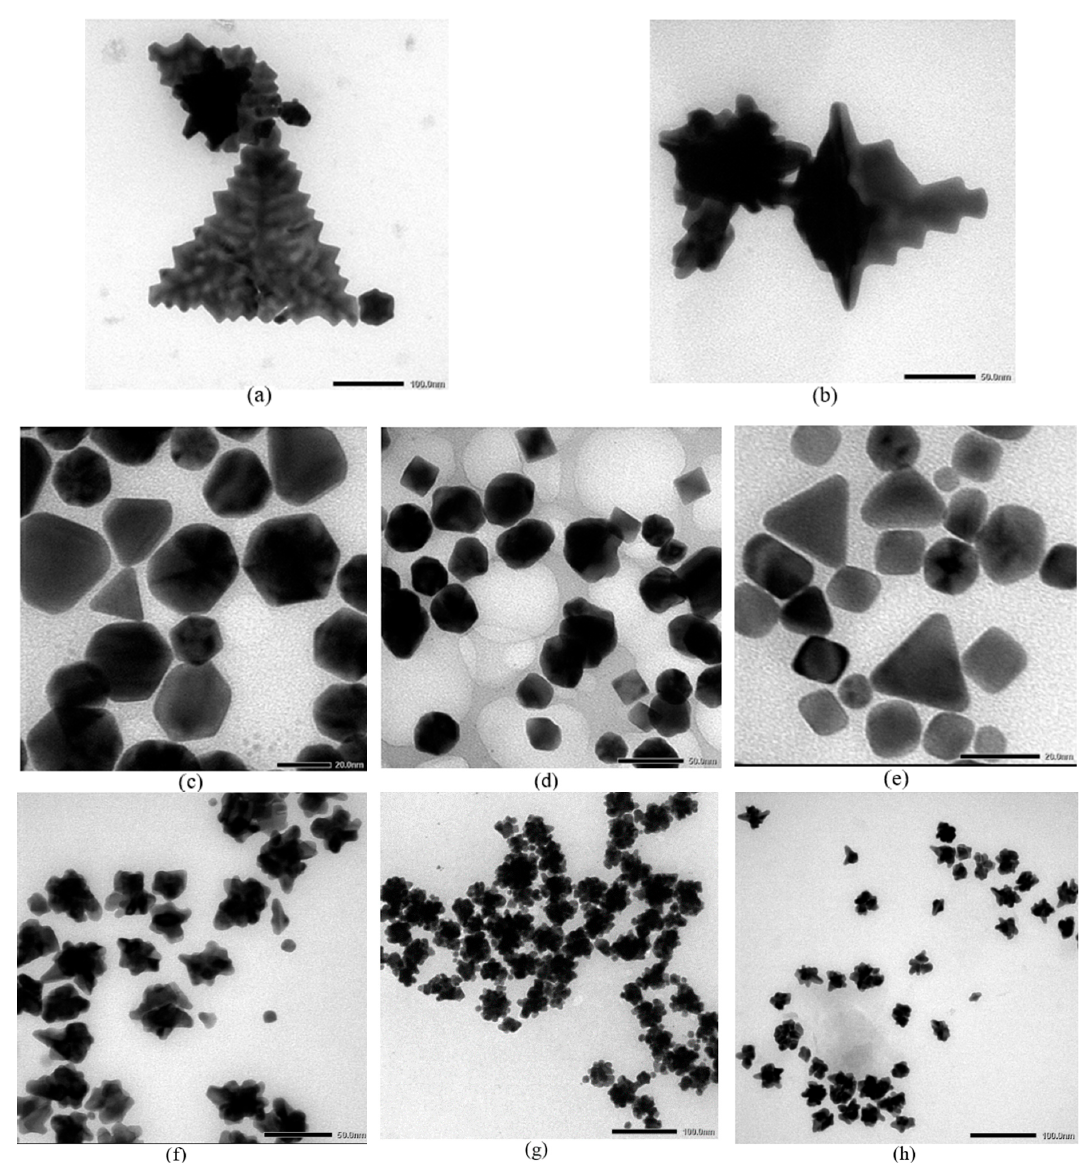
Figure 5. Representative TEM images of synthesized AuNPs at different pH value: ( a ) pH 3.0 (scale 100 nm); ( b ) pH 4.0 (scale 50nm); ( c ) pH 5.0 (scale 20 nm); ( d ) pH 6.0 (scale 50 nm); ( e ) pH 7.0 (scale 20 nm); ( f ) pH 8.0 (scale 50 nm); ( g ) pH 9.0 (scale 100 nm) and ( h ) pH 10.0 (scale 100 nm).